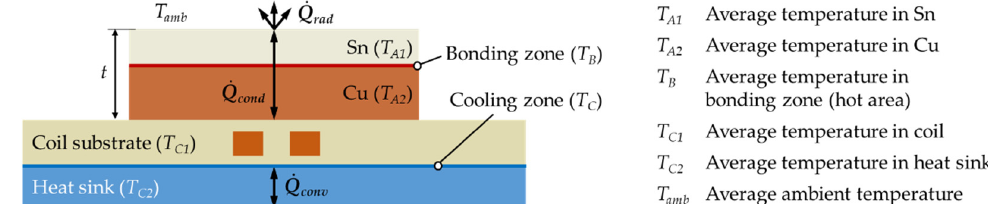
Figure 1. Illustration of the conventional heat transfer modes convection, conduction, and radiation using the example of a setup with two bond partners, a coil substrate, and a heat sink.